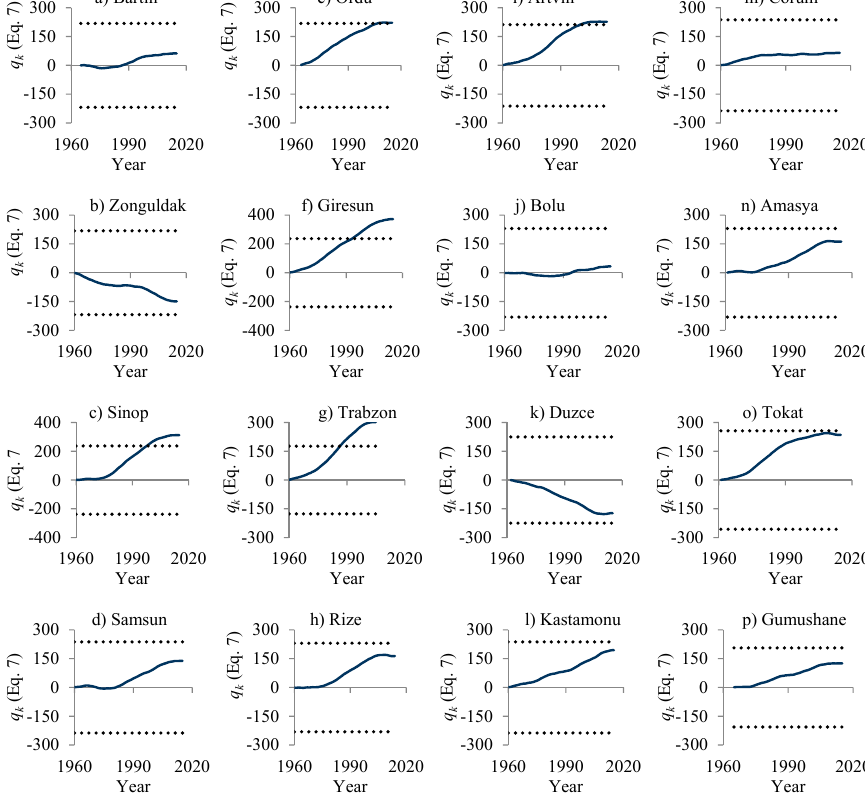
Figure 4. CSD-based graphical diagnoses of the trend significance for annual rainfall at stations ( a – p ) selected across the study area.